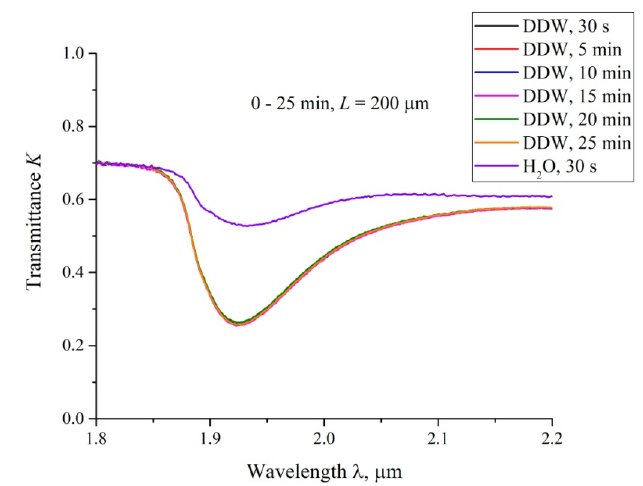
Figure 7. The transmittance spectra in the range 1.8 < λ < 2.2 µ m for DDW for the distance between the windows, L = 200 µ m. The graphs are related to the times of swelling 0.5, 5, 10, 15, 20 and 25 min. The upper curve is related to the transmittance spectrum for ordinary water; the time of swelling is 0.5 min.